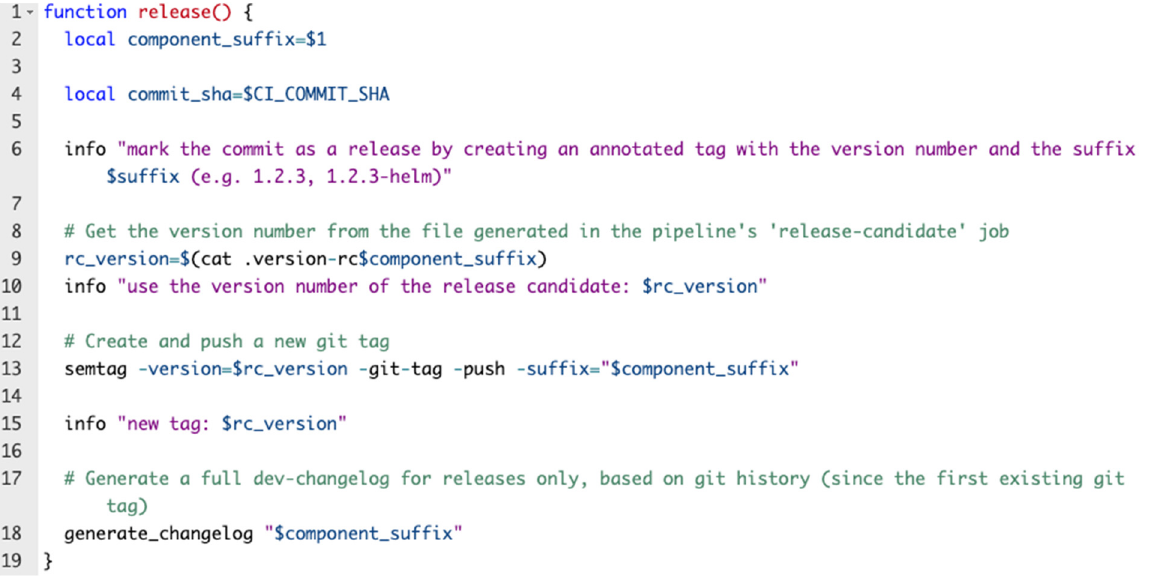
Figure 5. Versioning code block.